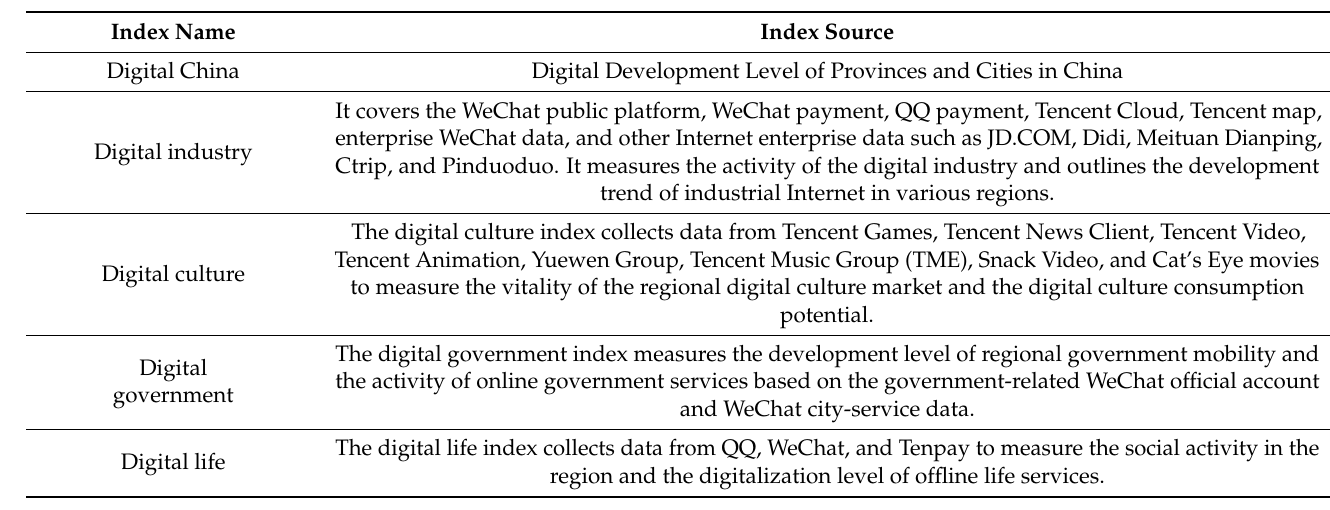
Table 1. Tencent digital data